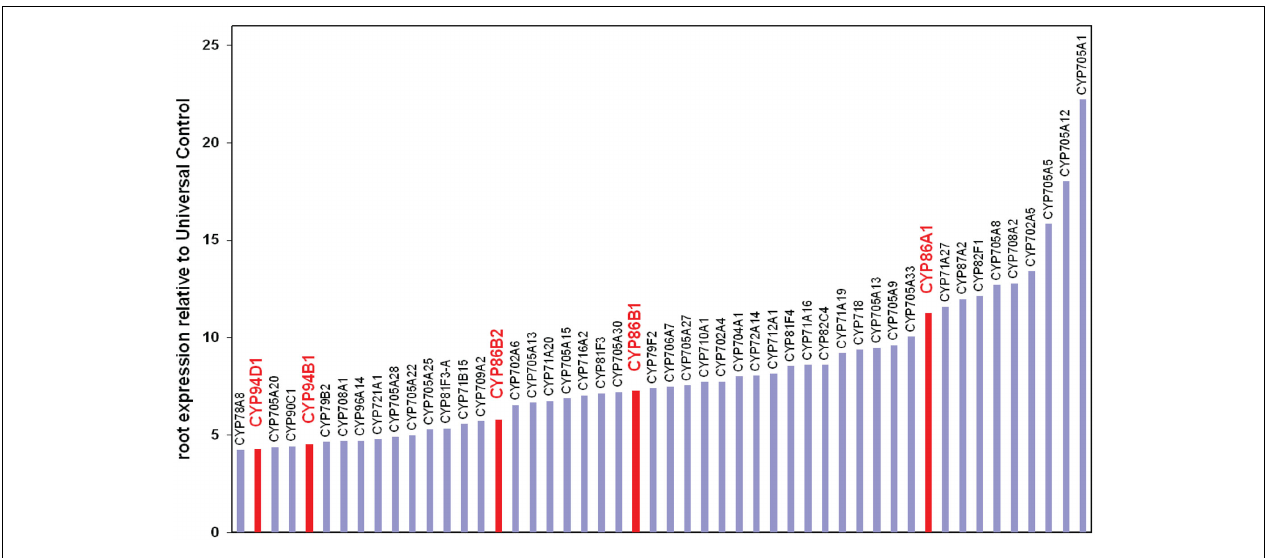
(http://arabidopsis-p450.biotec.uiuc.edu). Expression values are normalized relative to a universal control created from a control RNA pool derived from all aerial tissues and roots. Putative ω -hydroxylases are indicated in